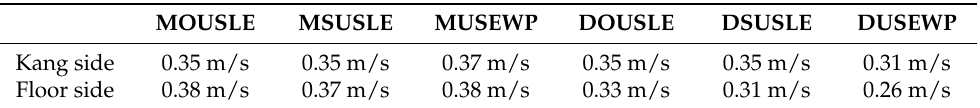
Figure 15. Contours of indoor 1.2 m high plane air velocity distribution under six schemes: ( a ) MOUSLE, ( b ) MSUSLE, ( c ) MUSEWP, ( d ) DOUSLE, ( e ) DSUSLE, ( f ) DUSEWP. Table 7. The average air velocity on the kang side and the floor side when the ventilation volume is Q = 141 m 3 /h.